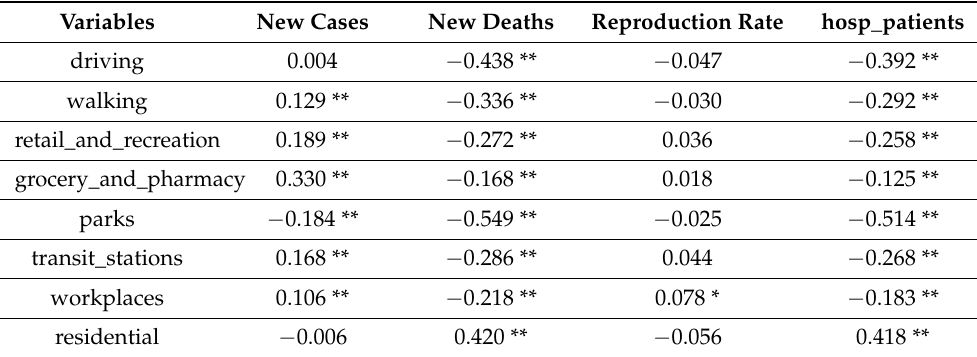
Table 8. Spearman’s r s correlation indexes calculated between variables indicating mobility and intensity of the disease for